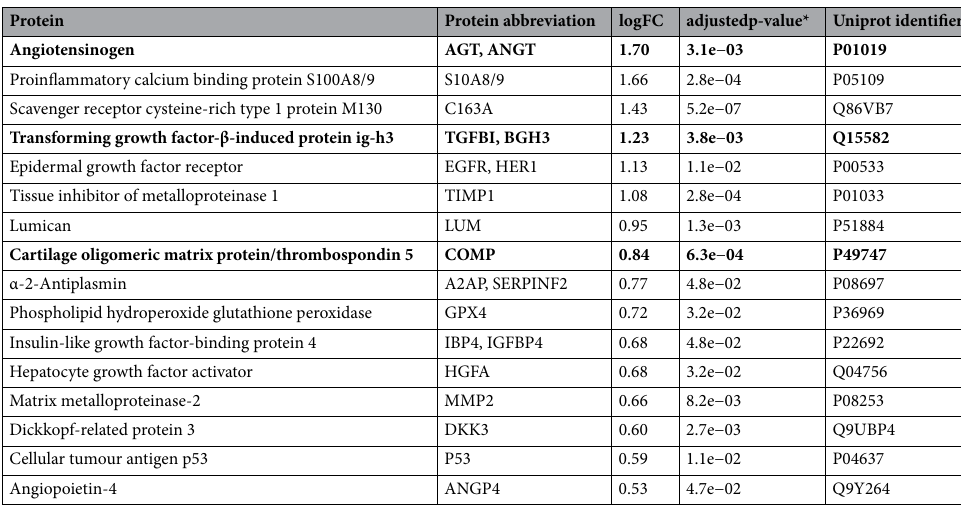
Table 3. Proteins with different levels in the peritoneal fluid from endometriosis patients versus control patients. The proteins given in bold were selected for the validation study. *p values adjusted for multiple testing according to Bonferoni and